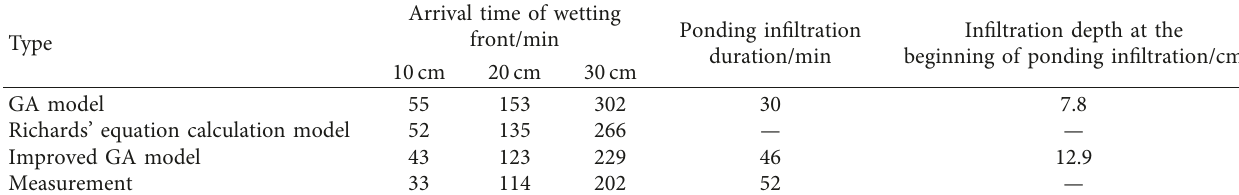
Table 2: Statistical table of measured data and model calculated parameters.